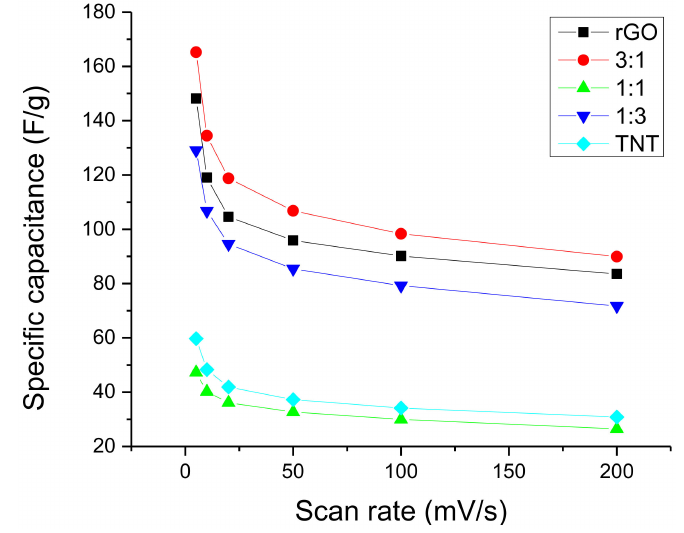
Figure 12. Specific capacitance variation with scan rate of rGO/TNT